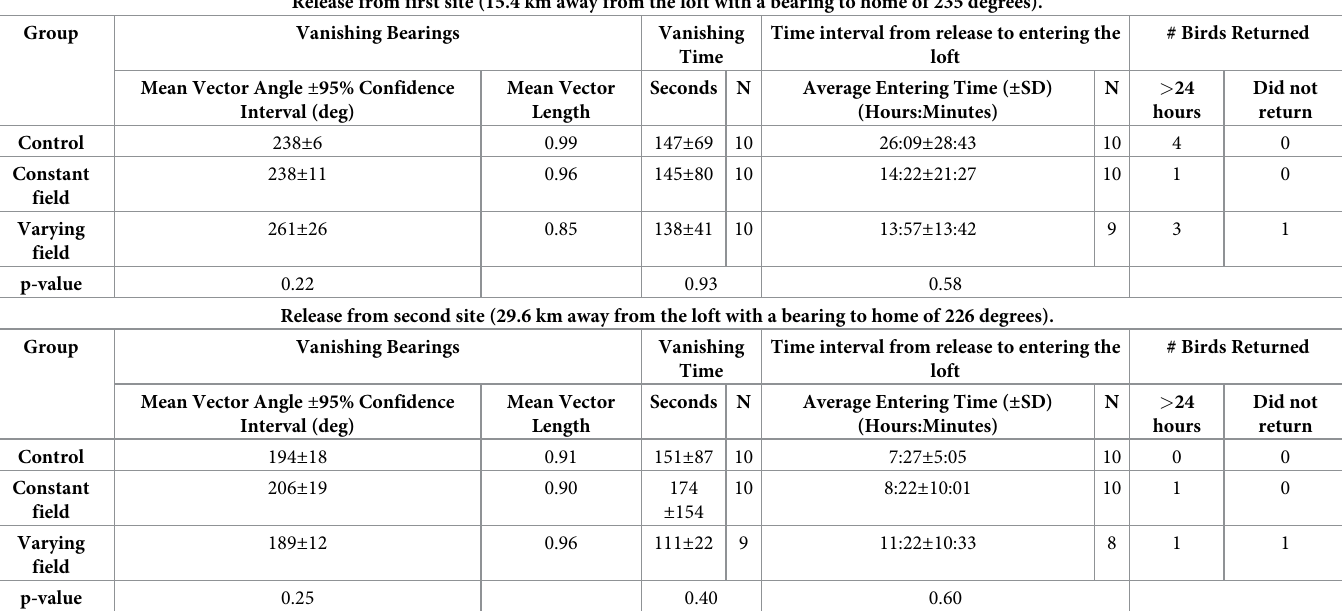
Table 1. Summary of homing data for the different